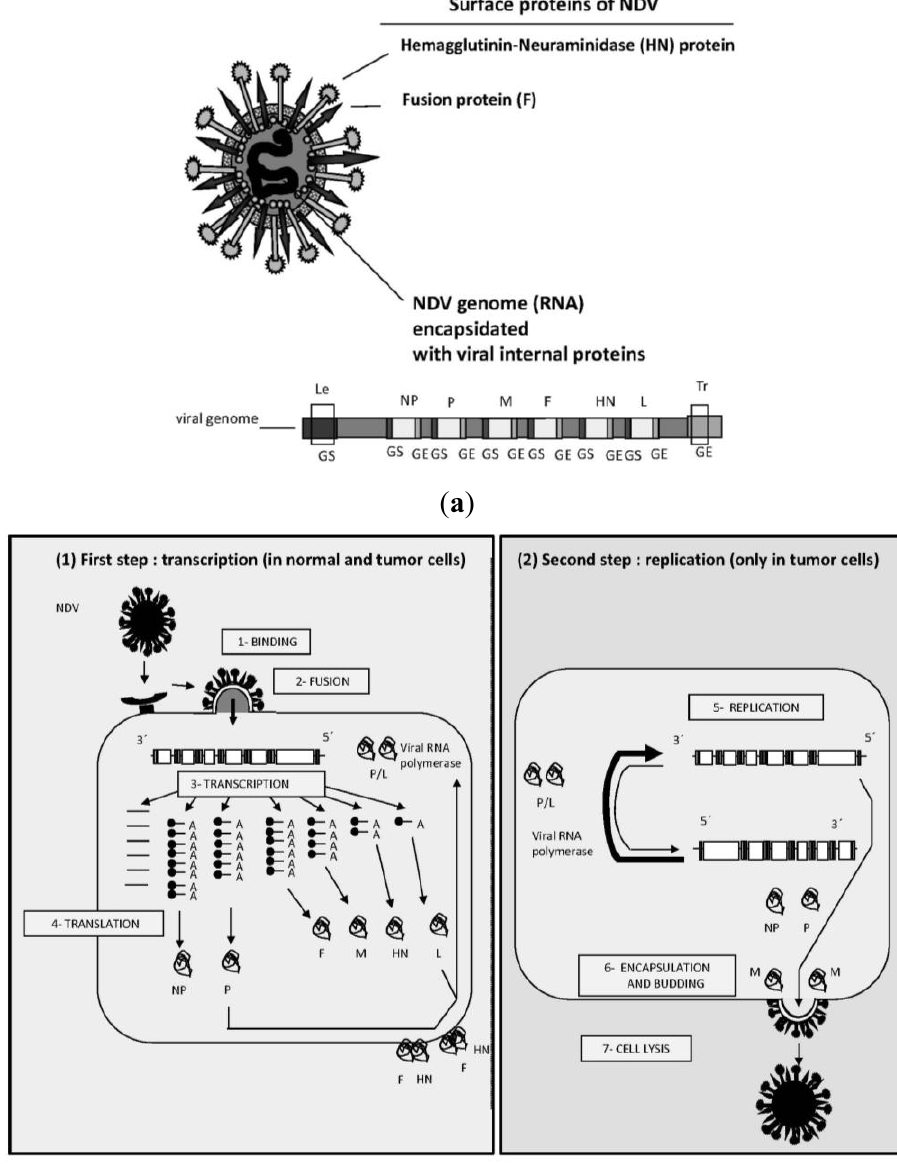
Figure 1. Newcastle Disease Virus: ( a ) structure; ( b ) replication in vitro (see the main text for more